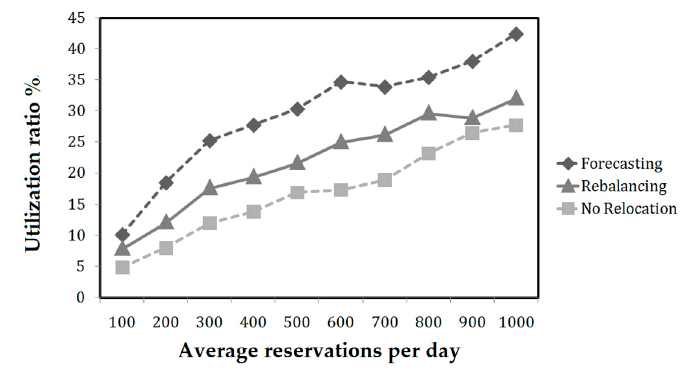
Figure 10. Impact of the number of reservations on vehicle utilization.